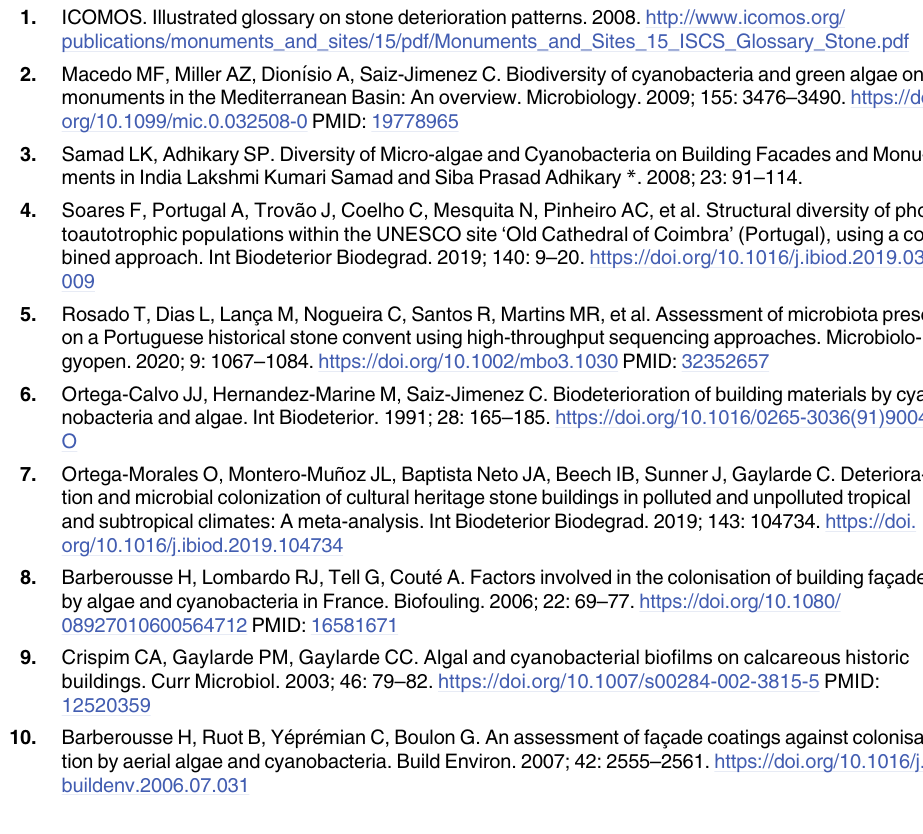
S1 Table. Meteorological data and microbial concentration for each positions. (tempera- ture T in ˚C, relative humidity RH in %, rain quantity in mm) and concentrations of green algae (‘algae’) and cyanobacteria (‘cyano’) for each day of the 2 measurements campaigns.